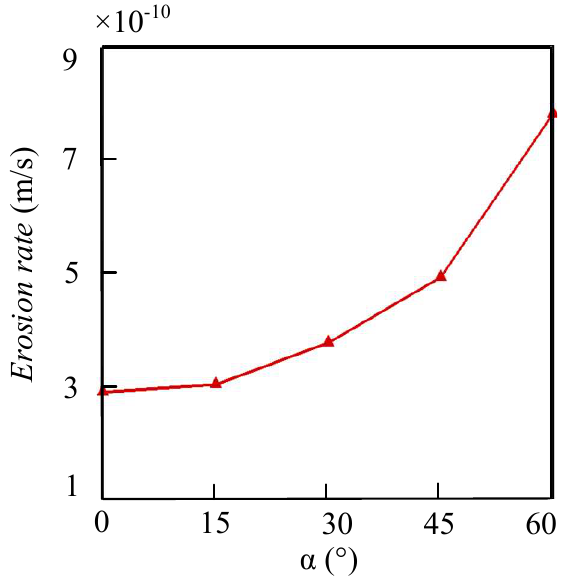
Figure 10. The average erosion rate of the dielectric wall with different values of the positive α